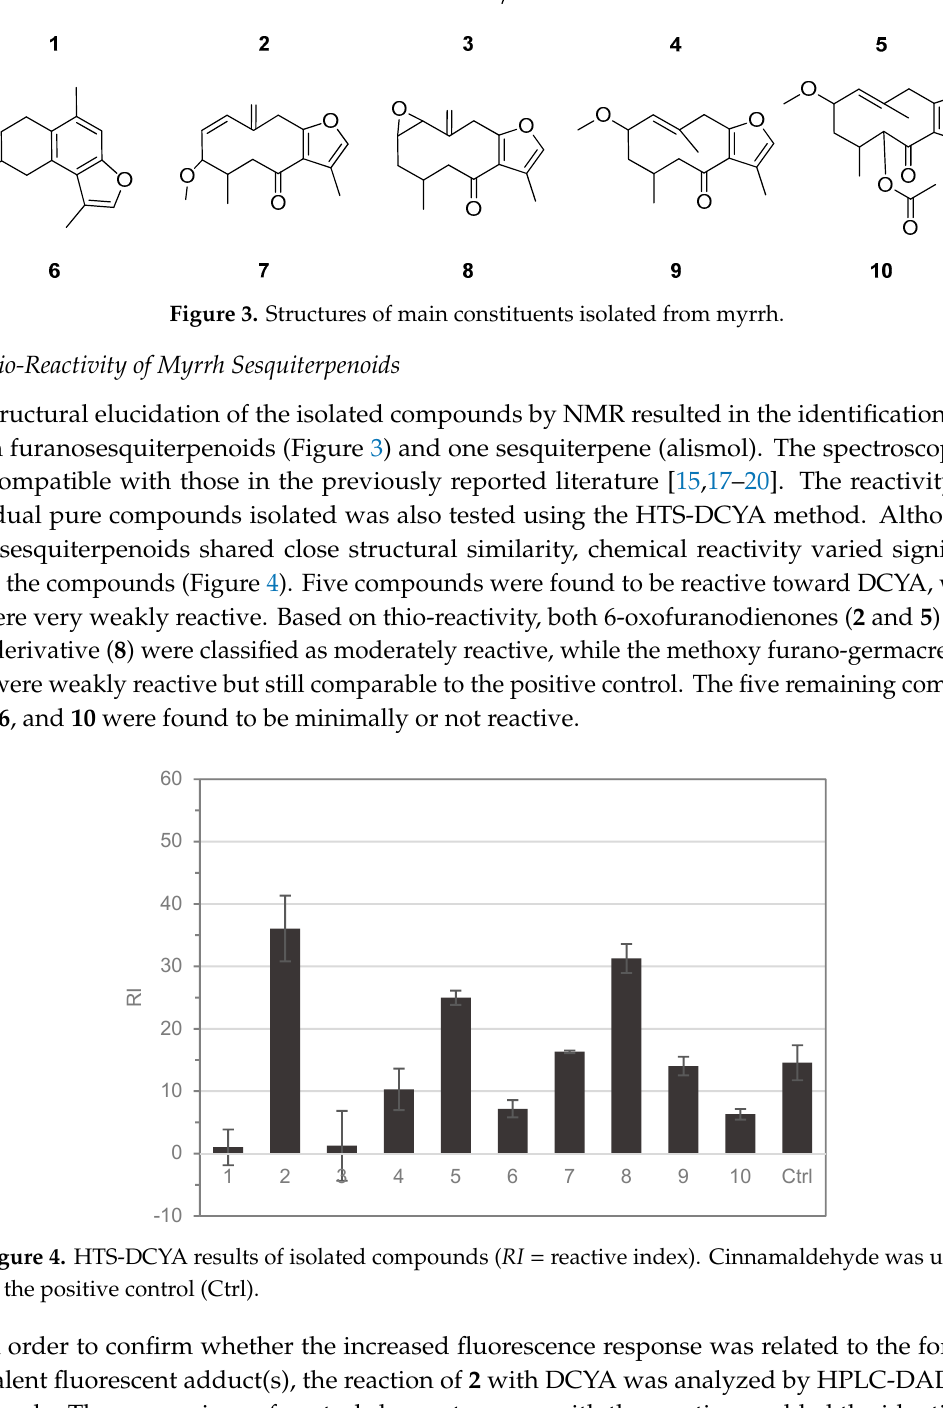
Figure 4. HTS-DCYA results of isolated compounds ( RI = reactive index). Cinnamaldehyde was used as the positive control (Ctrl).